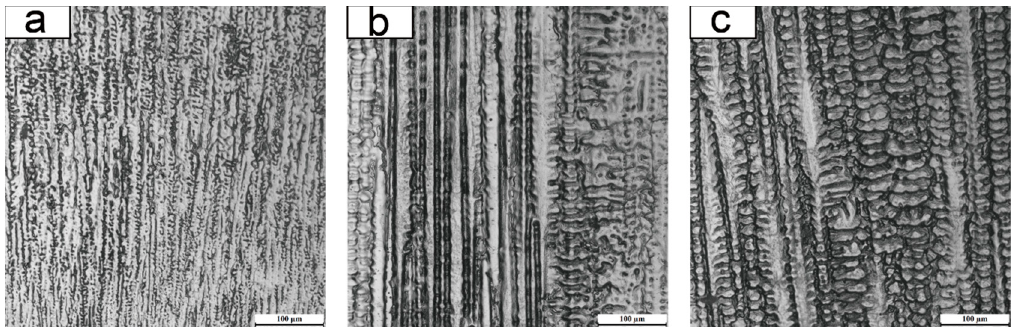
Figure 7. Microstructural photos of each region along the building direction of the as-deposited wall: ( a ) Bottom, ( b ) middle, and ( c ) top.